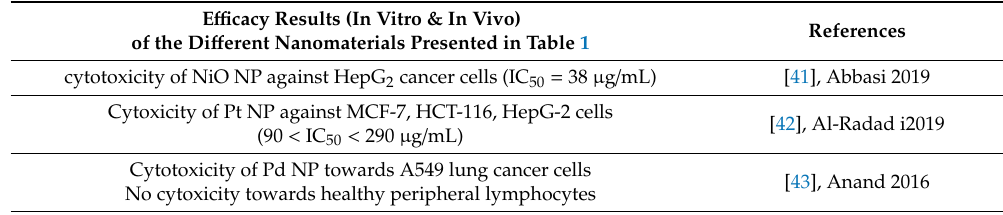
Table 2 summarizes the in vitro and in vivo anti-tumor e ffi cacies obtained with the various types of nanoparticles presented in Table 1. Table 2. Summarizes the in vitro and in vivo anti-tumor e ffi cacies of the various nanomaterials presented in Table